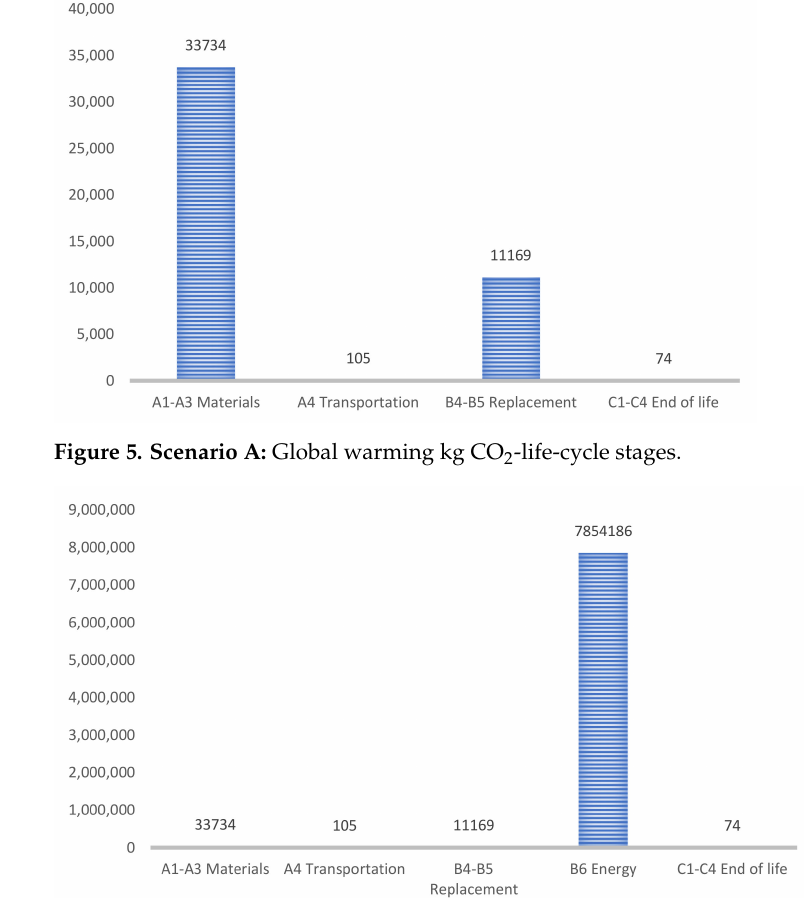
Figure 6. Scenario A: Global warming kg CO 2 , calculated considering the amount of operational